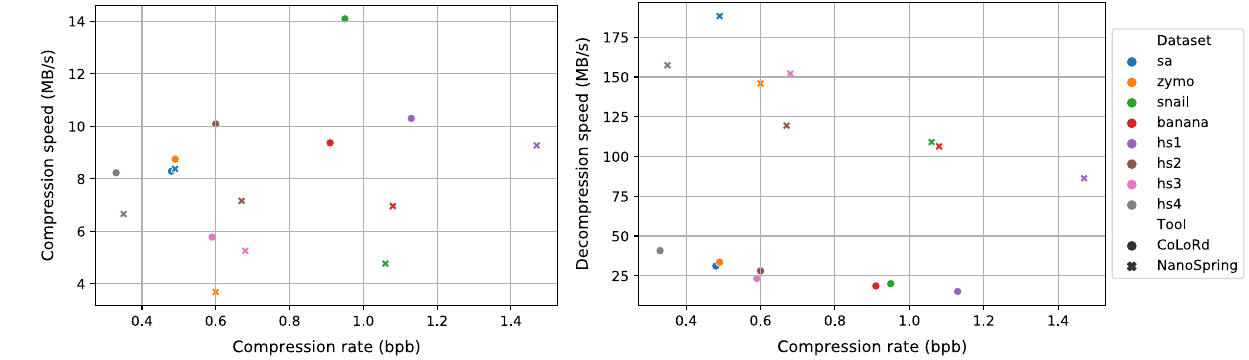
Figure 2. Compression and decompression speeds (MB/s) for CoLoRd and NanoSpring plotted against the compression rate in bits per base